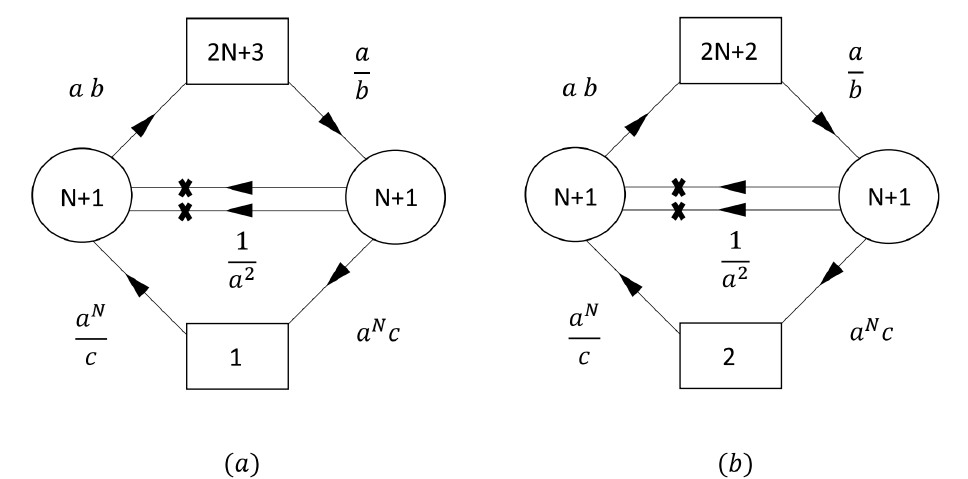
Figure 12 . The 3 d theories associated with the compactification of the 5 d SCFTs UV completing the 5 d gauge theories SU( N + 1) k + (2 N + 4) F on a torus with flux. (a) is for the case of k = 1 , corresponding to the SU(2 N + 6) SCFT, with flux (1 , − 1 , 0 , 0 , . . . , 0) . (b) is for the case of k = 2 , corresponding to the SU(2) × SO(4 N + 8) SCFT, with flux (0 , 0; 1 , 1 , 0 , 0 , . . . , 0) . Additionally, the charges of the fields under the non-R symmetries are shown. In all cases there are no Chern-Simons